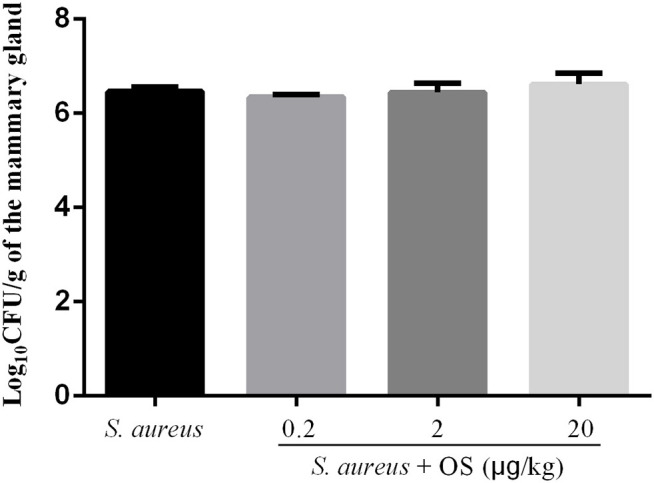
S. aureus load in the mammary glands. Values are presented as the mean Log10CFU/g of the mammary gland ± SEM (n = 5).